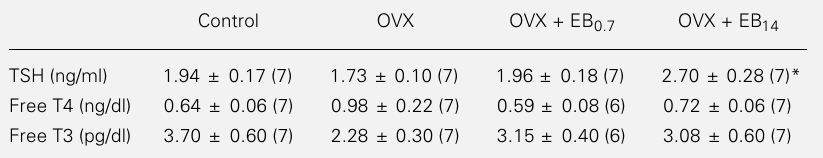
Table 1 - TSH, free T3 and free T4 of ovariectomized rats (OVX) chronically treated with different doses (0.7 or 14 µg/100 g body weight) of estradiol benzoate (EB). Data are reported as means ± SEM for the number of animals given in parentheses. *P<0.05 vs OVX (Kruskall-Wallis test followed by Dunn’s multiple comparison